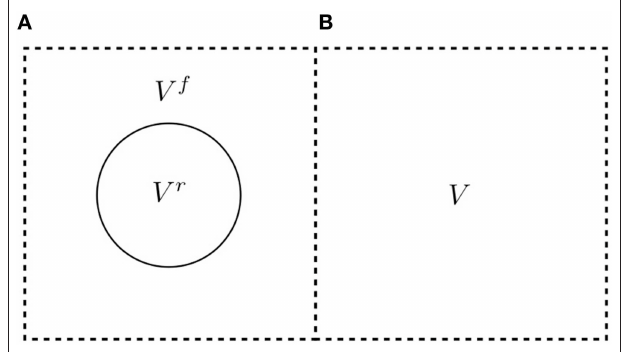
FIGURE 1 | A particle in a confined system (A) in equilibrium with a bulk fluid phase (B)